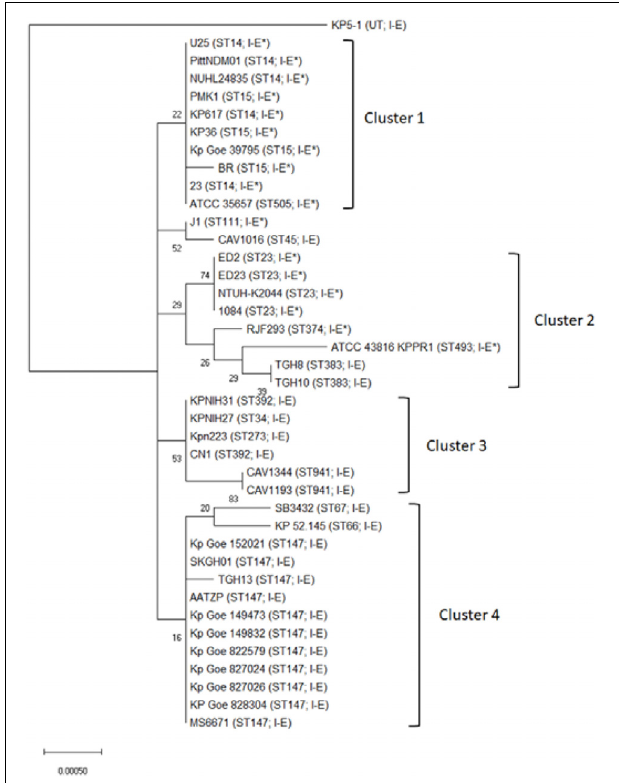
FIGURE 1 | Phylogenetic tree of the concatenated MLST sequences of 40 Klebsiella pneumoniae isolates. The phylogenetic tree was based on the aligned nucleotide sequences of concatenated MLST sequences of 40 K. pneumoniae isolates by using the Maximum Likelihood method. The percentage of trees in which the associated taxa clustered together is shown next to the branches. The tree is drawn to scale, with branch lengths measured in the number of substitutions per site. Sequence types and CRISPR-Cas subtypes appear in brackets. UT,